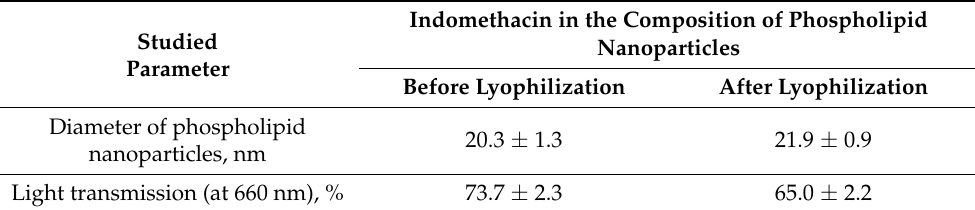
Table 1. Characteristics of indomethacin composition before and after drying.